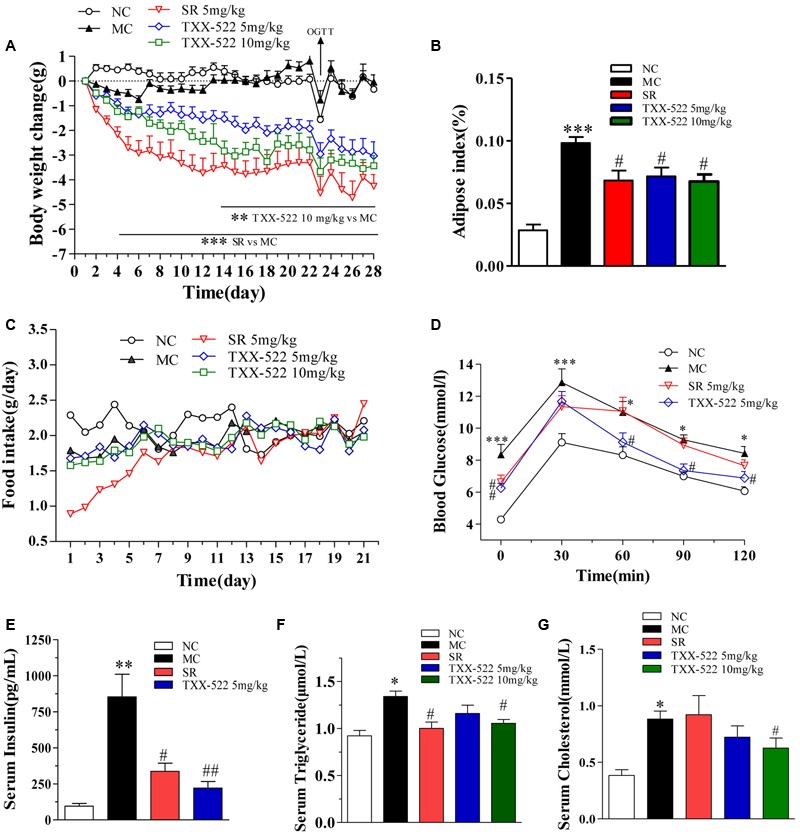
In vivo pharmacodynamic effects of TXX-522 and SR141716A in diet-induced obese (DIO) mice. (A) Body weight change was calculated individually and then averaged. (B) Intra-abdominal white adipose weight. (C) Food intake was calculated daily and then averaged. (D) Oral glucose tolerance testing was performed on treatment day 23 in overnight-fasted mice. (E) Fasted serum insulin. (F,G) Serum triglyceride and total cholesterol levels. Compounds were administered to DIO mice by oral gavage for 28 days. NC, normal control; MC, model control; SR, SR141716A. Data are means ± SEM of 8–9 animals per group. ∗P < 0.05, ∗∗P < 0.01, ∗∗∗P < 0.001 vs. NC group; #P < 0.05, ##P < 0.01 vs. MC group.